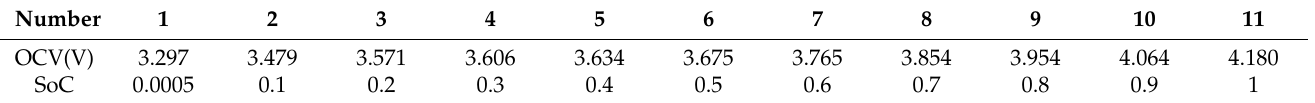
Table 2. Data points of SoC-OCV.